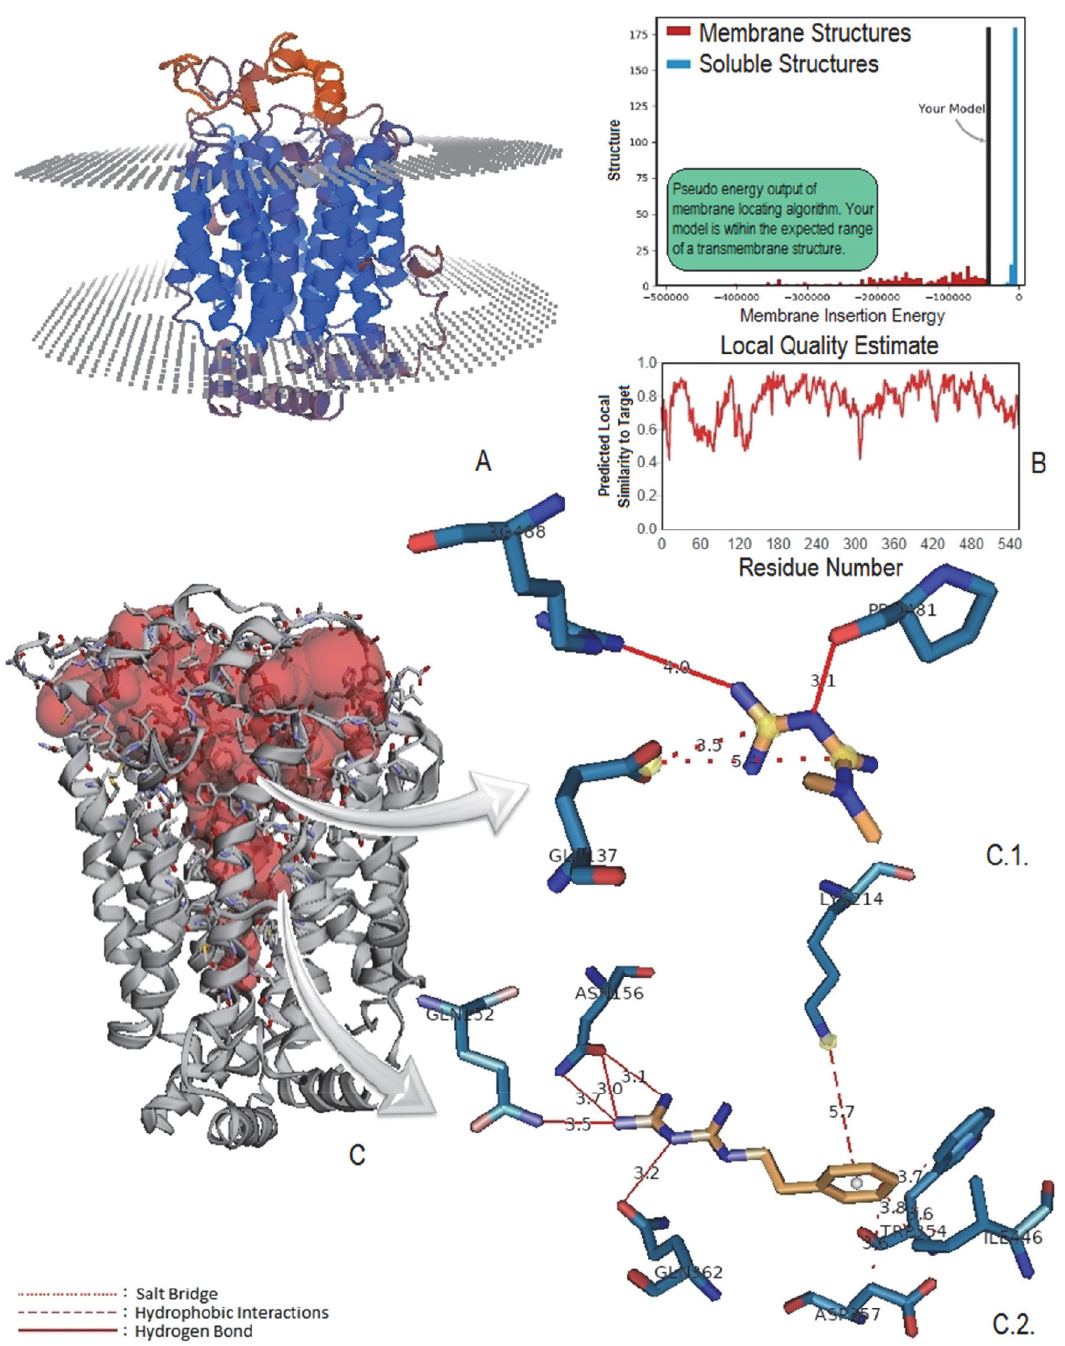
Figure 3. The representation of the molecular modeling of OCT-1 and metformin, and phenformin. A. OCT-1 transmembrane protein embedded in the plasma membrane model was predicted by QMEANBrane. B. Structure validation of modeled OCT-1 concerning membrane insertion en- ergy and the local quality estimate of the residues of the model OCT-1. C. The surface of the binding pocket of the model OCT-1 as computed using CASTp 3.0. Molecular simulation of the best pose of the interaction of OCT1 and metformin(C1), phenformin(C2) with the highest docking